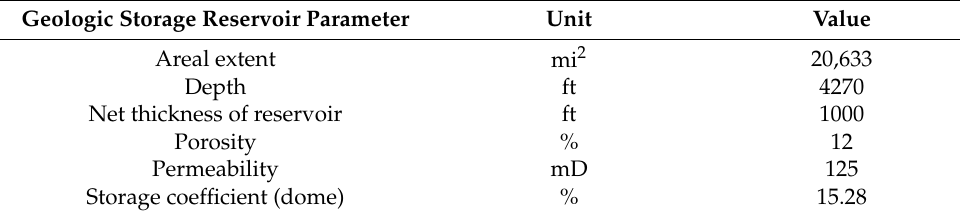
Table A3. Geologic characteristics for the Mount Simon 3 reservoir in CO 2 _S_COM. Geologic Storage Reservoir